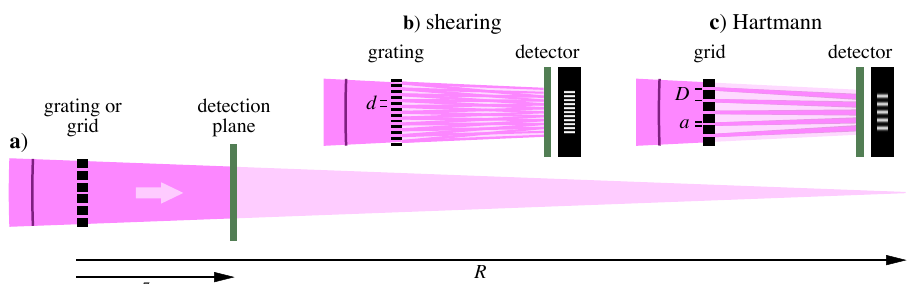
Figure 1. ( a ) Beam geometry used in the single-grating shearing interferometry and Hartmann wavefront. A converging (shown) or diverging beam, incident from the left, is transmitted by a shearing grating or Hartmann grid and propagates a distance z to the detection plane. The grating-to- focus distance is R (negative in the diverging-beam case). Inset details show ( b ) shearing geometry with grating pitch d and ( c ) Hartmann geometry with grid pitch D and opening width a